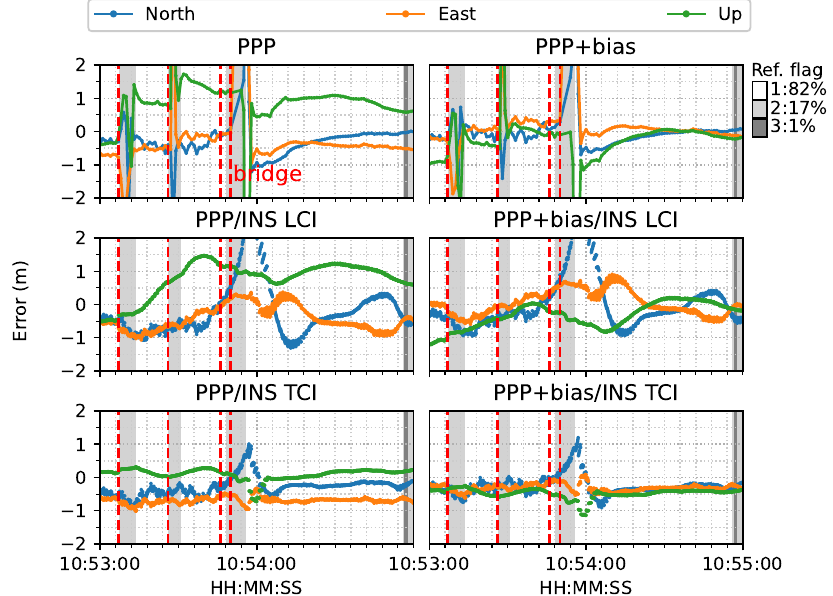
Figure 17. Re-convergence example 1. The red lines indicate the epochs under bridges (The same